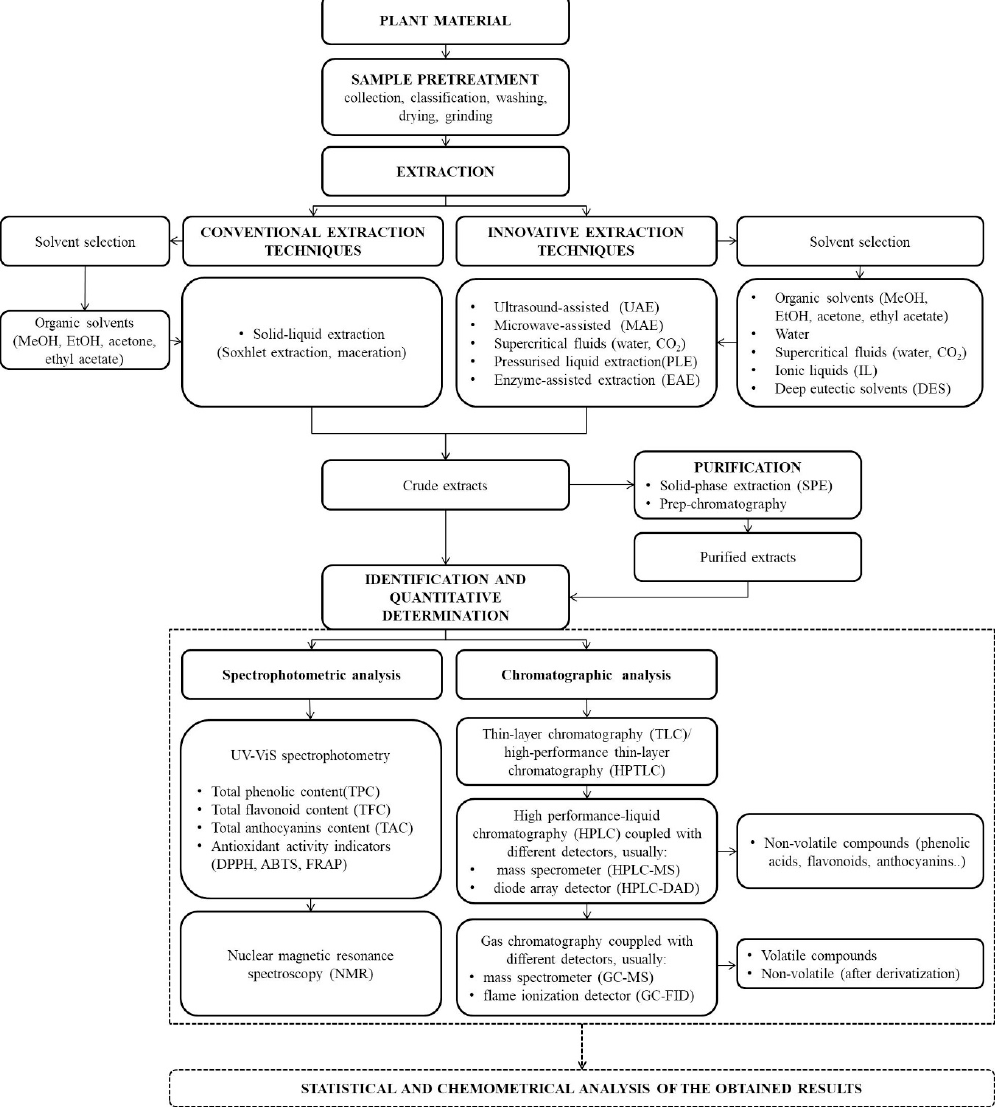
Figure 1. Flow chart of the general analytical protocol for the determination of bioactive compounds from plant material.